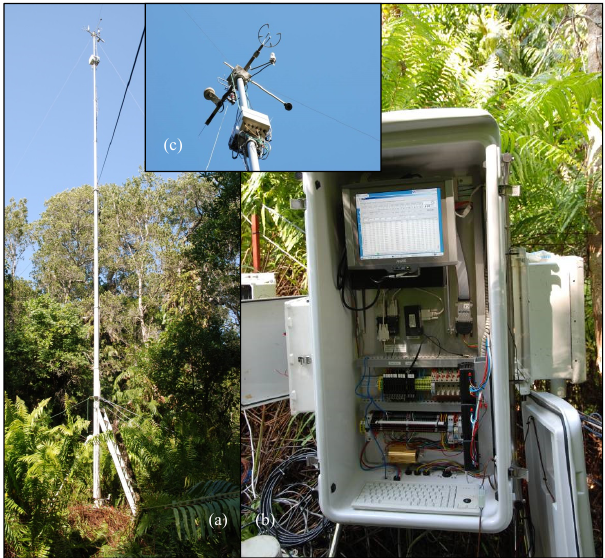
Figure 3. (a) Telescopic mast (21.3m) erected in the swamp forest to raise the eddy covariance instruments above the forest canopy, (b) the computer installed at the swamp forest, housed in a temper- ature controlled enclosure and (c) the instruments attached to the head of the